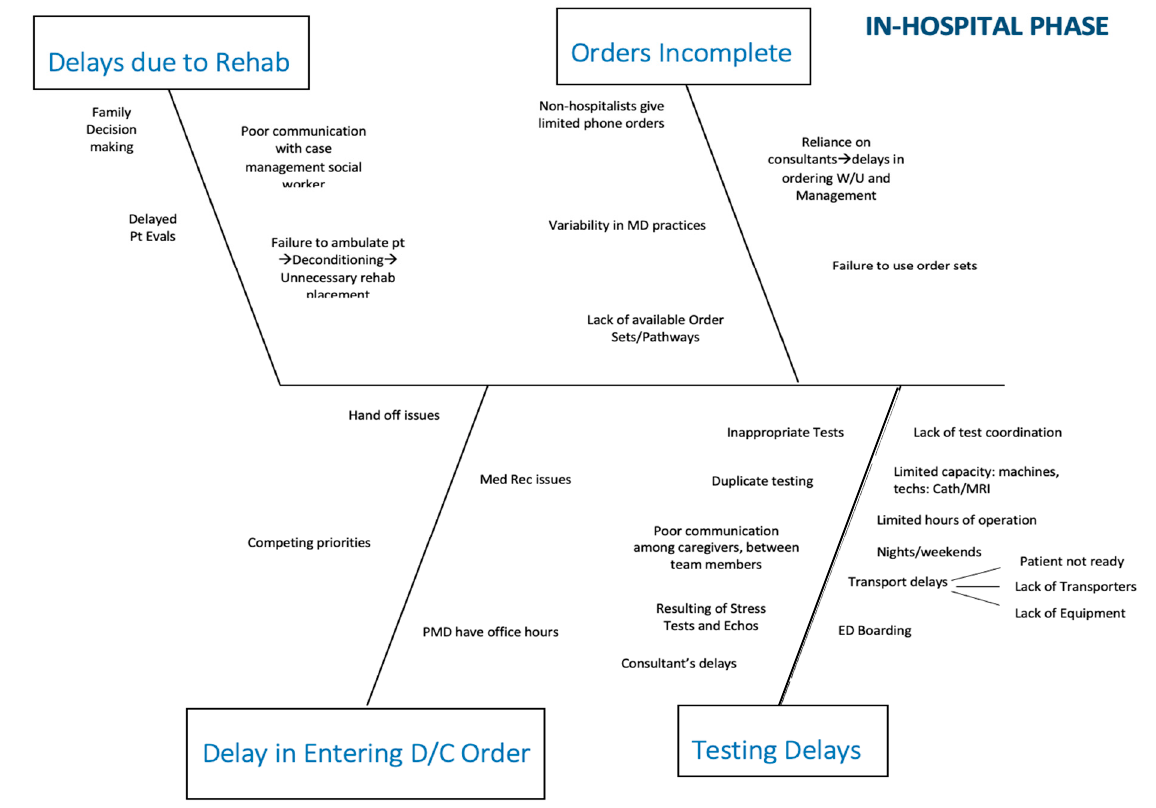
Figure 1. Fishbone diagram representing in-hospital phase delays, including orders and testing.